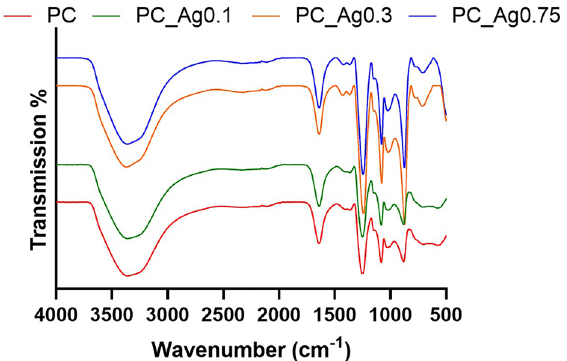
Figure 4. FTIR spectra of the undoped (PC) and silver doped (PC_Ag)